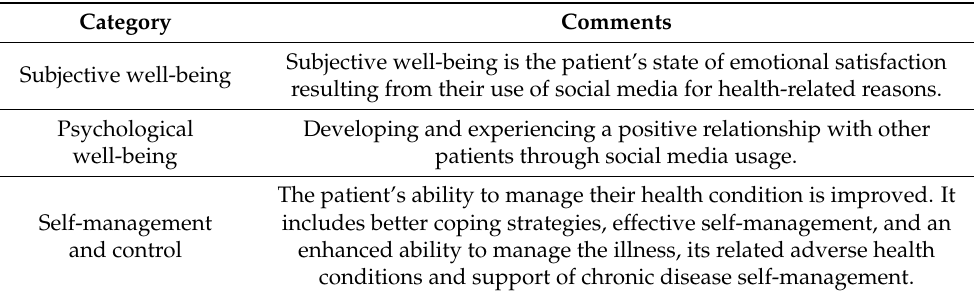
Table 2. Three subcategories of